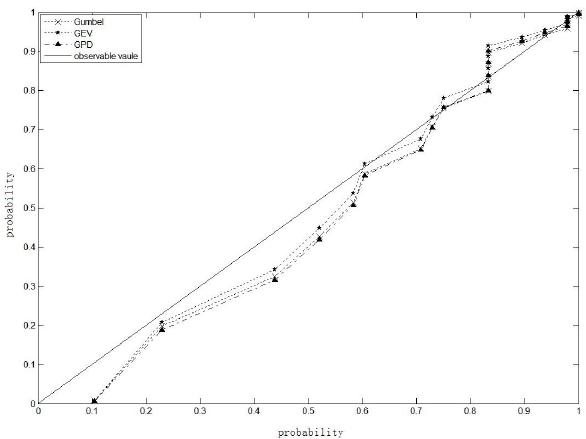
Fig. 2. Comparison of fit lines from Gumbel, GEV and GPD mod- els.